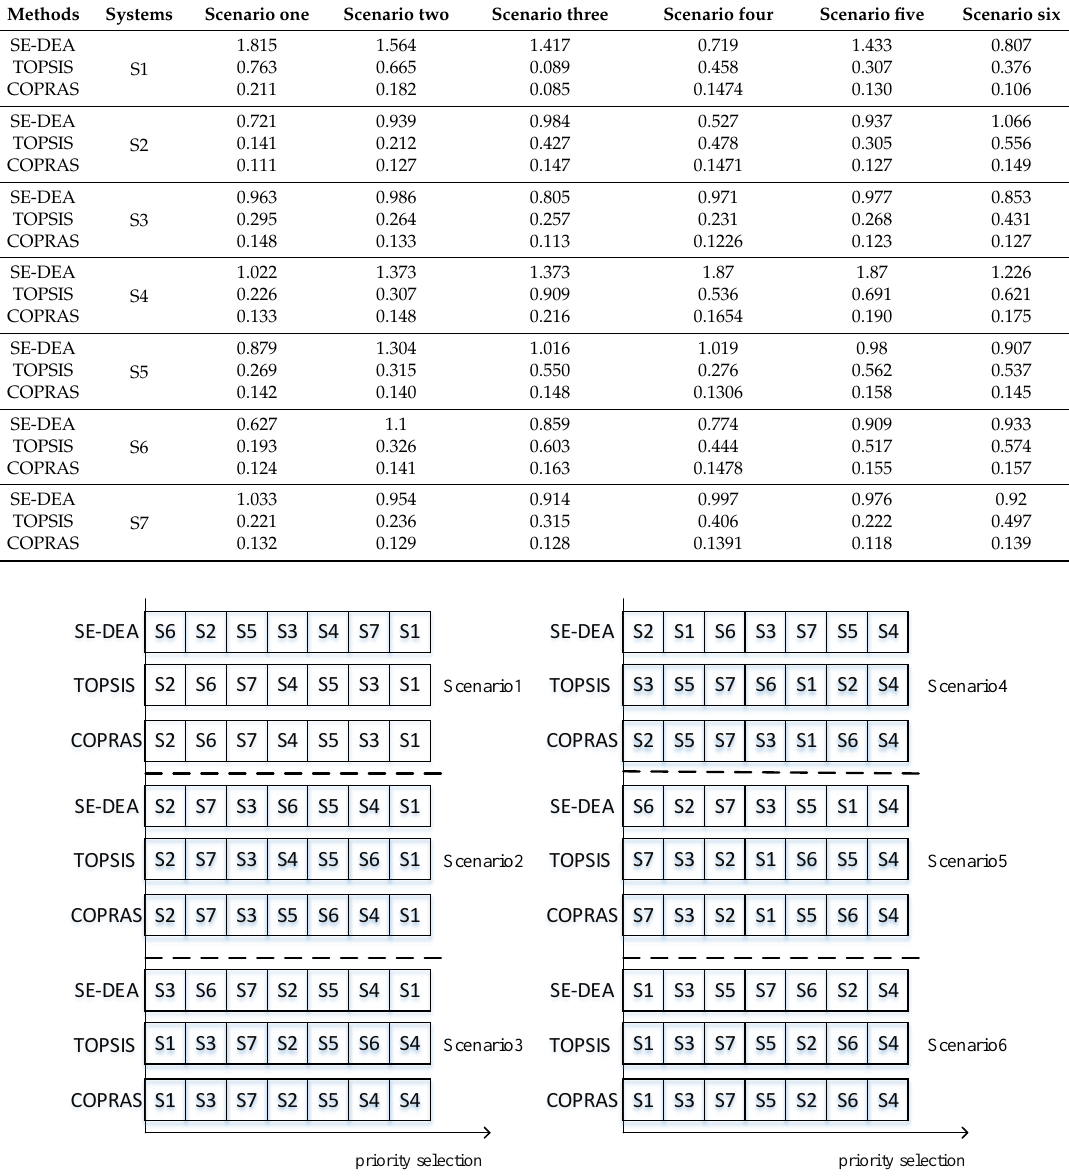
Table 9. Priority values for various scenarios with different methods.